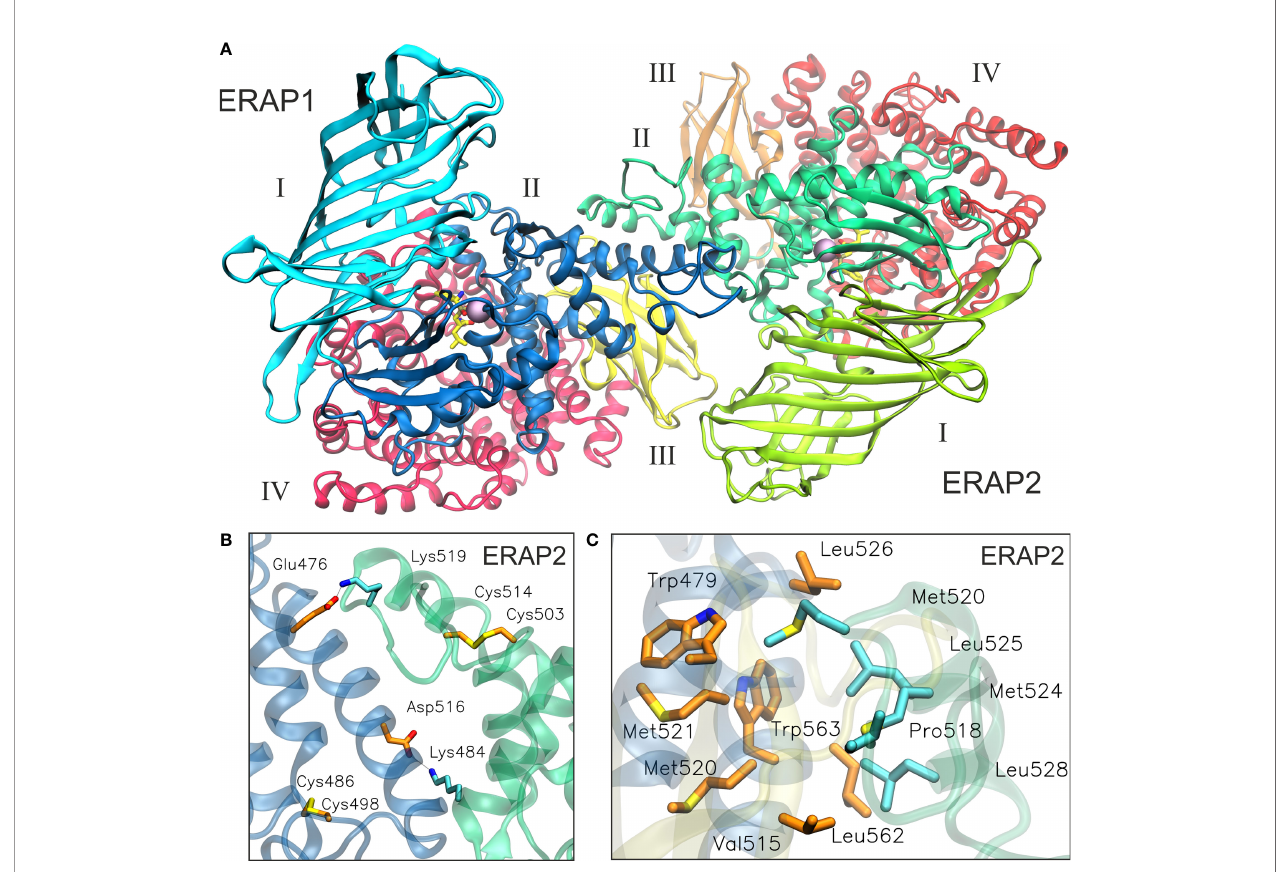
FIGURE 5 | (A) The proposed heterodimeric ERAP2/ERAP1 model B2 from a representative snapshot taken from a 100-ns MD simulation. The snapshot is the centroid of the highest populated cluster of conformations that represents 64% of the trajectory within 2 Å RSMD of all C a atoms. (B) Close-up view showing two key salt – bridge interactions between helices 8 of ERAP1 (orange C atoms) and ERAP2 (cyan C atoms). The disul fi de bridges that stabilize exon 10 loops are shown as sticks. (C) Another close-up view of the dimeric interface illustrating hydrophobic/aromatic interactions between ERAP1 (orange C atoms) and ERAP2 (cyan C